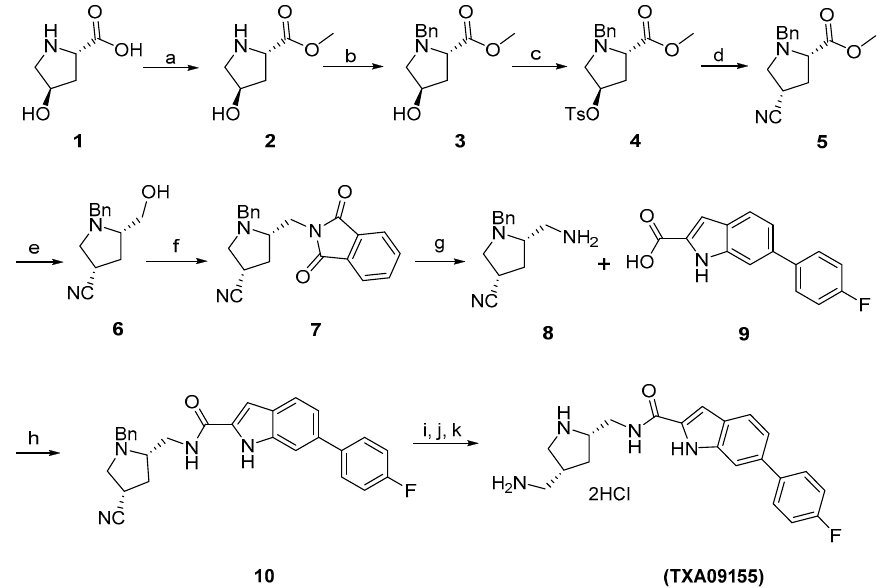
Figure 7. Synthetic Scheme for the preparation of TXA09155. ( a ) SOCl 2 , MeOH, 0 °C-room